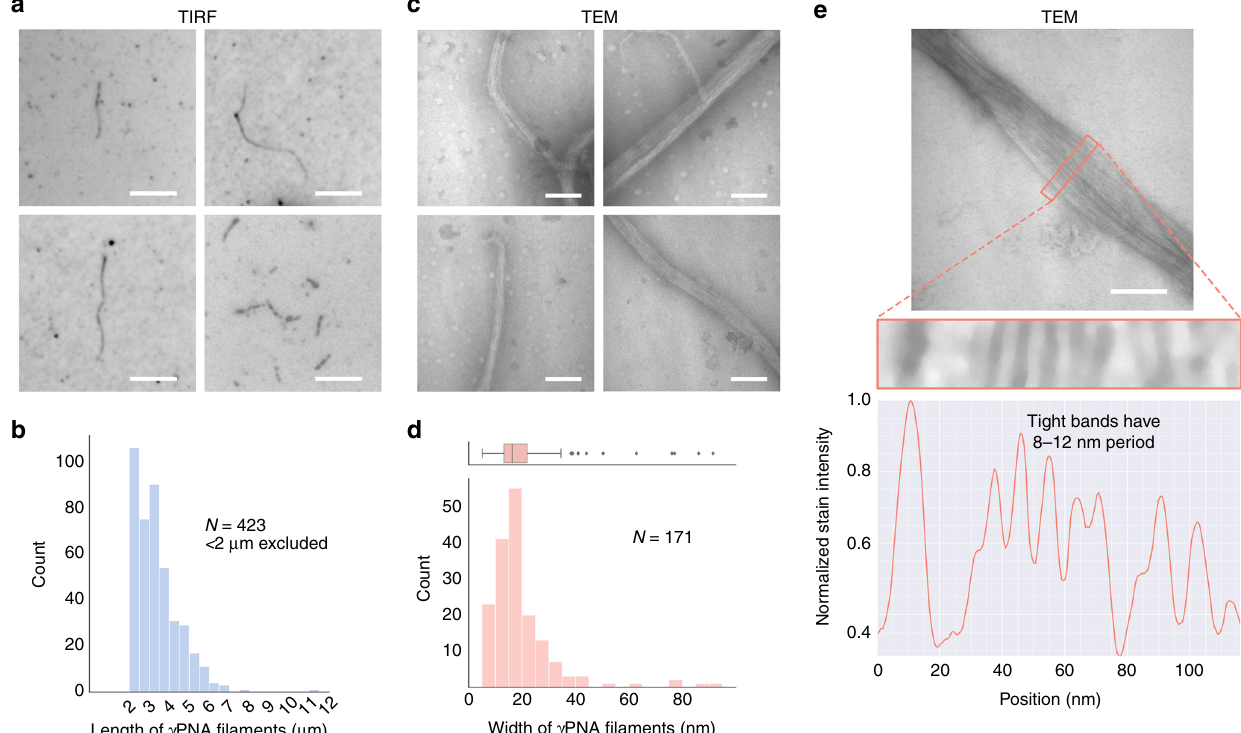
Fig. 2 Evidence and characterization of self-assembly of γ PNAs to form 3-helix nano fi bers using TIRF and TEM assays. a TIRF panels (5 μ m scale